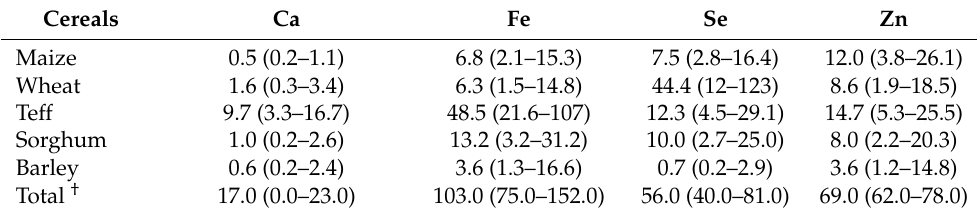
Table 3. Median district-level dietary contribution (%) of staple cereals to mineral micronutrient estimated average requirement for adult women in